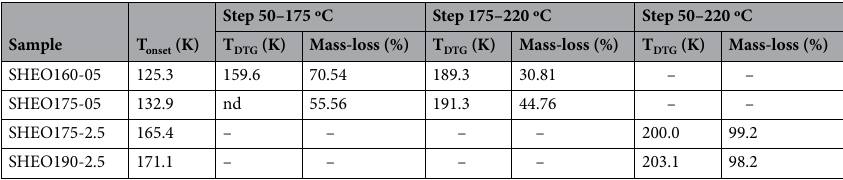
Table 2. Thermal parameters from TG/DTG curves for SHEOx-y